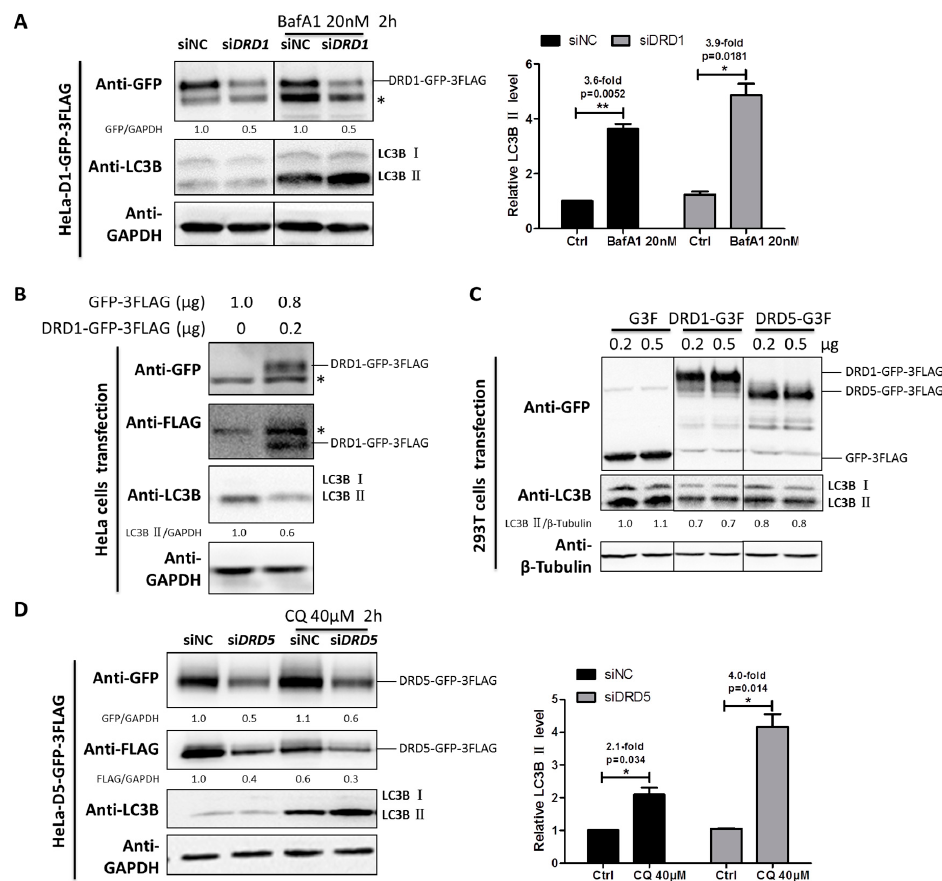
Figure 2. DRD1 and DRD5 knockdown promote autophagic flux. ( A ) DRD1 RNAi was combined with autophagy inhibitor Baf A1 (20 nM) for 2 h to detect the autophagic flux in HeLa cells stably expressing DRD1-GFP-3FLAG. ( B ) Total of 1 μ g of MSCV-DRD1-GFP-3FLAG and MSCV-GFP-3FLAG plasmids were transfected into HeLa cells using lipofectamine 2000 for 48 h. ( C ) 0.2 or 0.5 μ g MSCV-DRD1/DRD5-GFP-3FLAG or MSCV-GFP-3FLAG plasmid was transfected into 293T cells using lipofectamine 2000 for 48 h. ( D ) DRD5 RNAi was combined with autophagy inhibitors CQ (40 μ M) for 2 h to detect the autophagic flux in HeLa cells stably expressing DRD5-GFP-3FLAG. The asterisk (*) indicates the nonspecific band. Experiments were repeated at least three times and representative Western blots are shown. Densitometric analysis was performed and quantification results were labeled below the corresponding blots or in separate panels. * p < 0.05, ** p < 0.01.